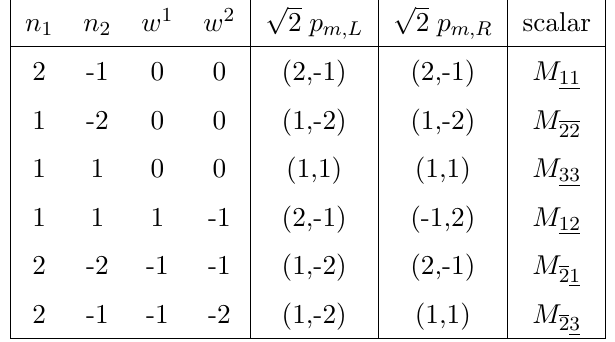
Table 3 . Some of the massless scalars with momentum and winding at the SU(3) L (cid:2) SU(3) R enhancement